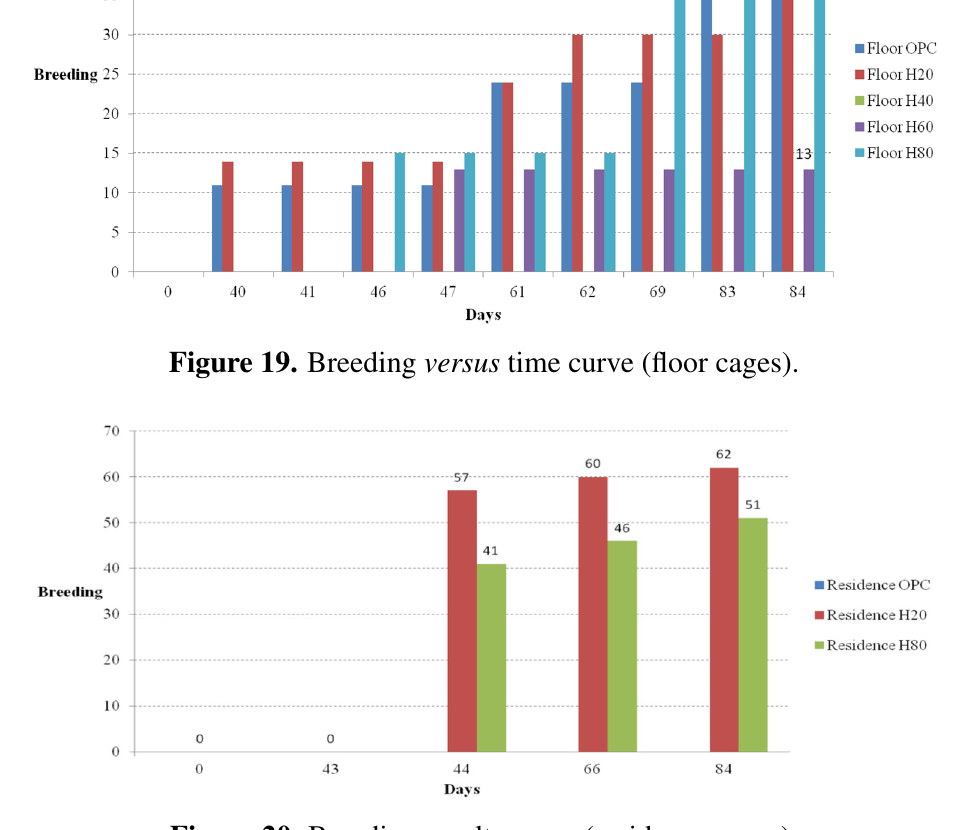
Figure 20. Breeding results curve (residence cages).